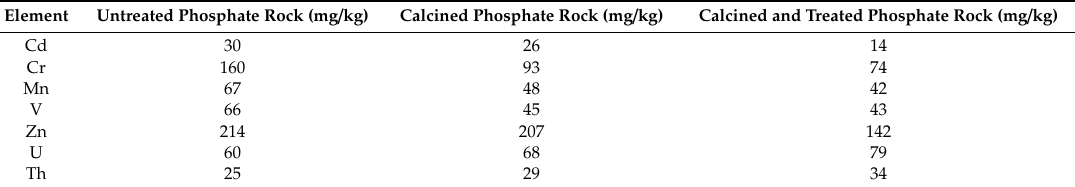
Table 3. Relevant Trace Elements in Untreated, Calcined, as Well as Calcined and Treated Sra Ouertane (Layer A1) Phosphate Rock.